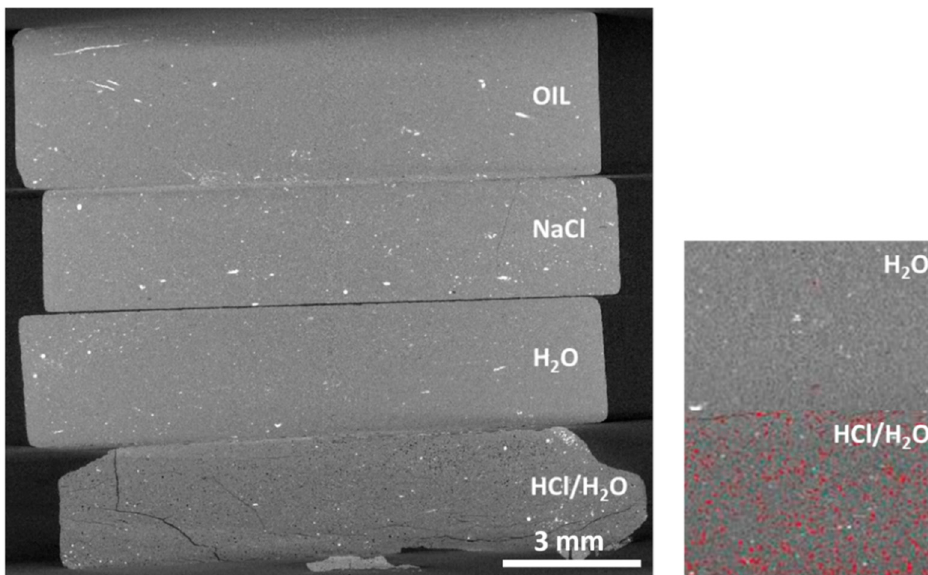
Figure 5. X-ray tomography cross-sectional image through shale disks exposed for 96 h to oil, 1 M NaCl, H 2 O and 1 M HCl/H 2 O, respectively, ( left ) and around 3 times enlarged images of shale samples exposed to H 2 O ( top ) and 1 M HCl and H 2 O ( bottom ) with micro-sized porosity highlighted in red being a consequence of mineral dissolution( right ).